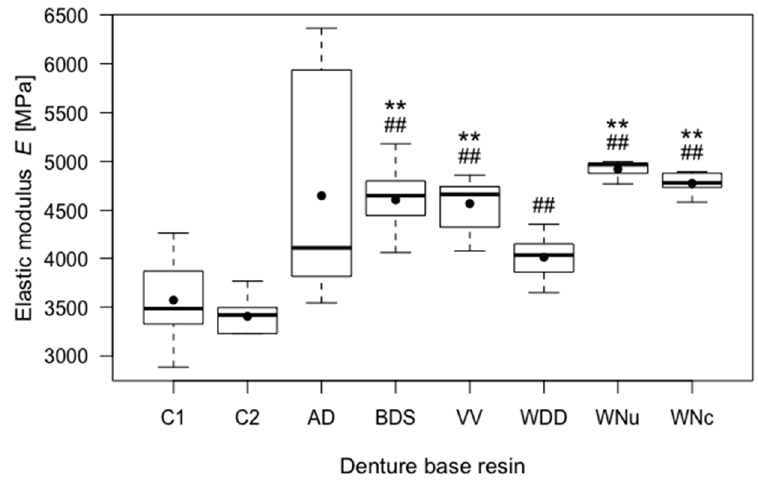
Figure 4. Boxplots of the elastic moduli ( E ) of the tested resins. ** indicates highly significant differences ( p < 0.01) with respect to control group C1, ## indicates highly significant differences ( p < 0.01) with respect to control group C2.